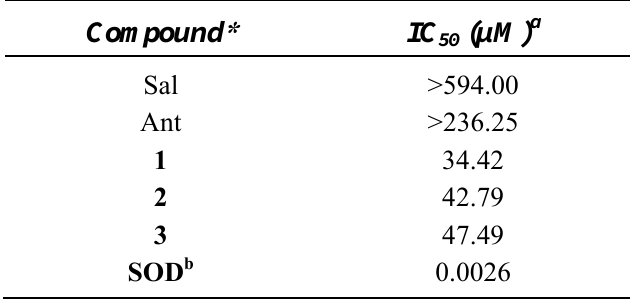
Table 3. Superoxide dismutase activity of the free ligands and copper